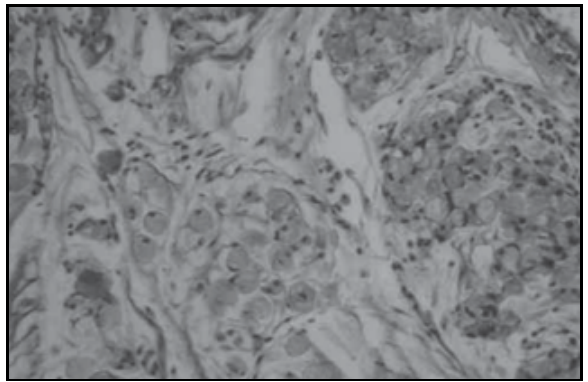
Figura 1 – Adenocarcinoma mucinoso com células em anel de sinete (HE, 400×) HE: hematoxilina e